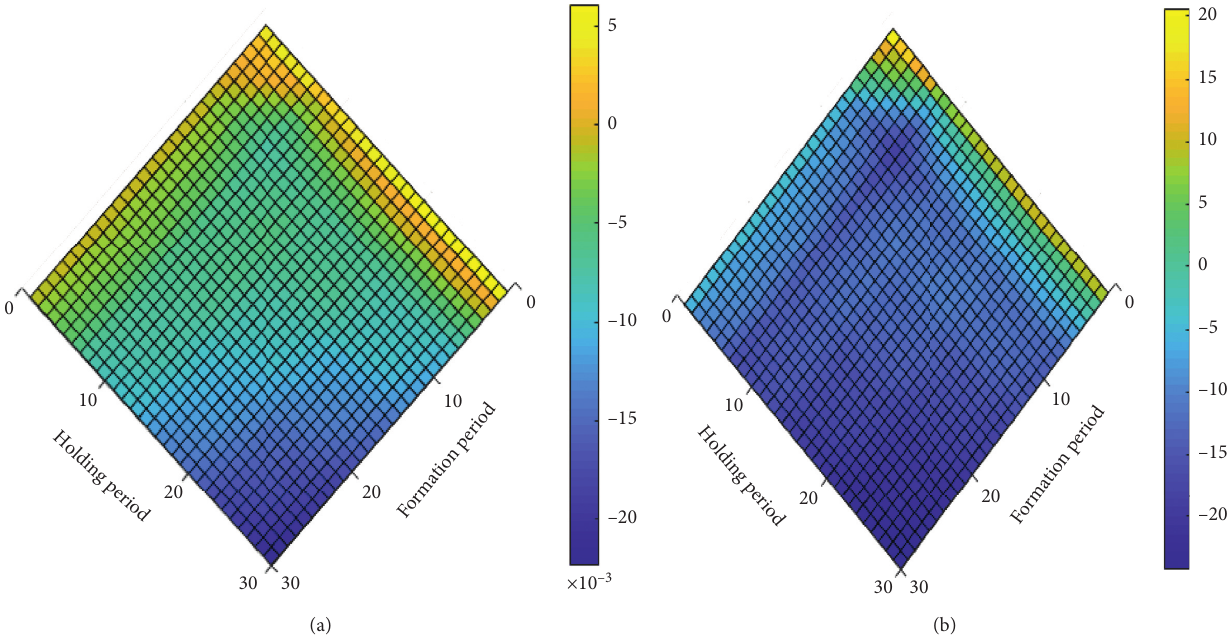
Figure 2: Momentum profits of the A-share market as a whole. This figure plots the momentum profits and related t -statistics of the A-share market in various periods. The formation and holding periods, respectively, range from 1 day to 30 days. (a) Momentum profit and (b) t -